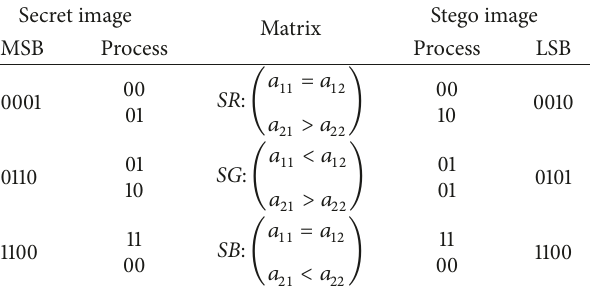
Table 3: Operation